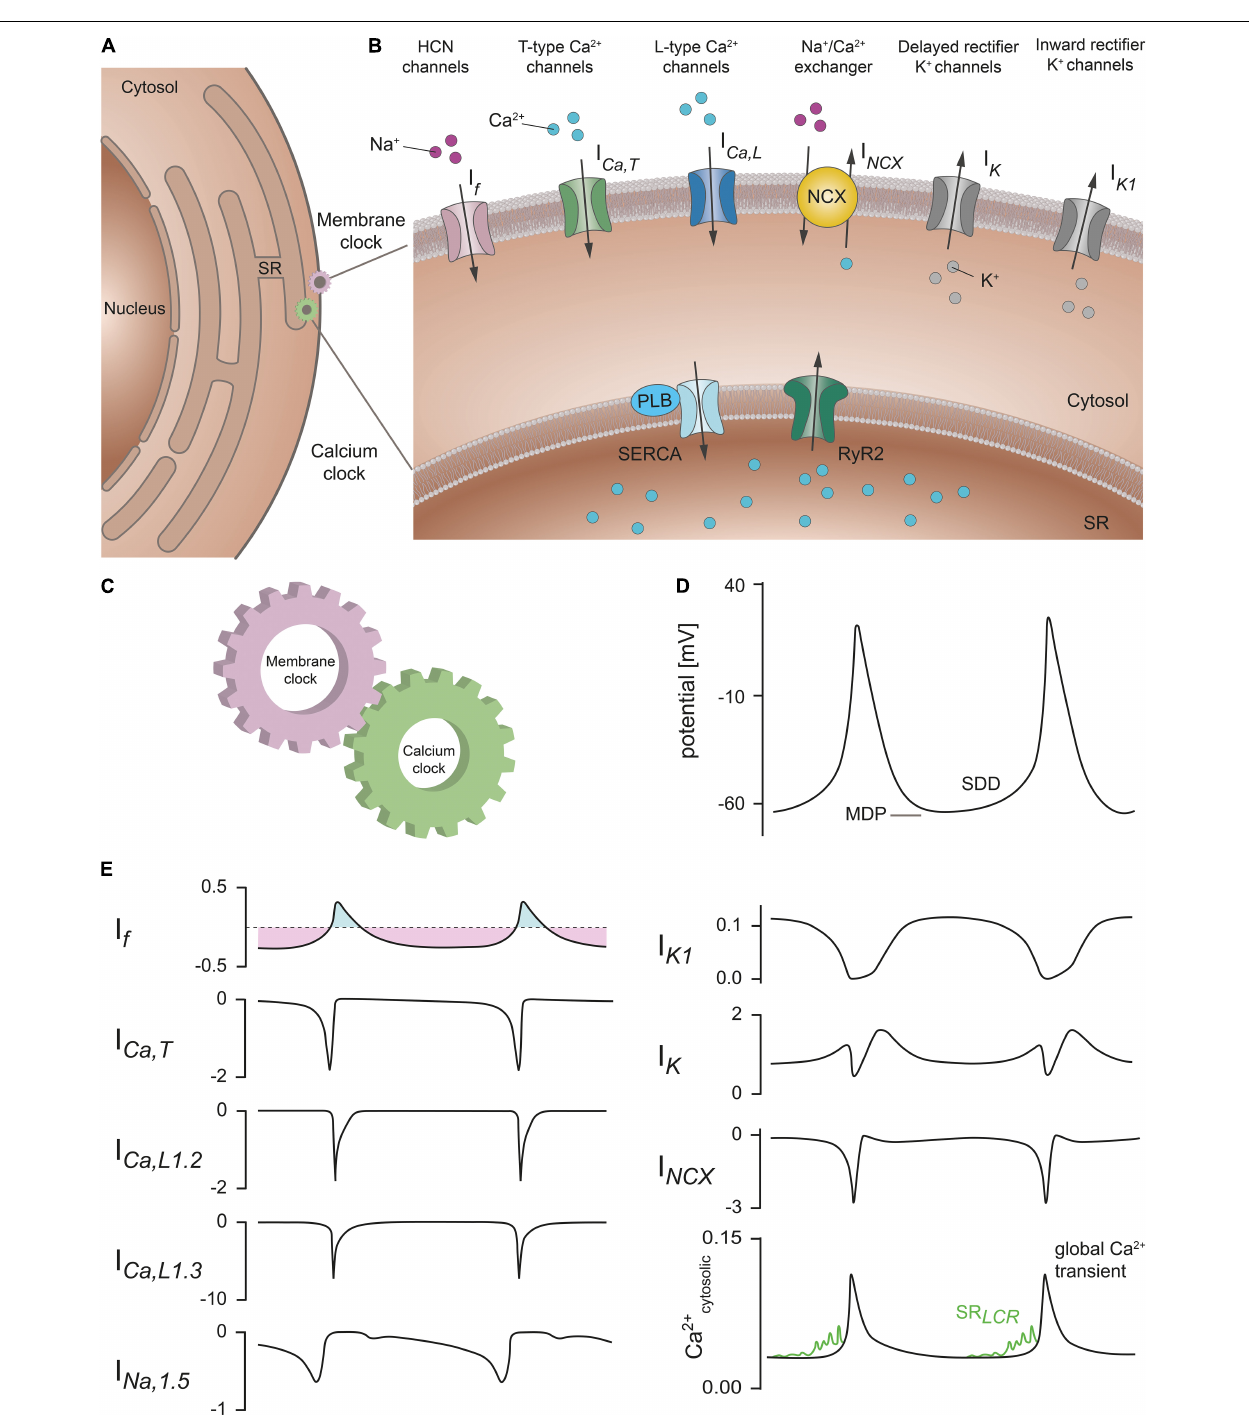
FIGURE 2 | Membrane and calcium clock contribute to the generation of SDD. (A) Schematic representation of a SAN cell containing the nucleus, cytosol, and sarcoplasmic reticulum (SR). (B) Section of the cell with a magnified view of the plasma membrane and SR membrane. Various proteins that contribute to SDD and are localized in the plasma membrane are collectively described as the membrane clock . These include hyperpolarization-activated cyclic-nucleotide gated (HCN) cation channels (pink), T-type Ca 2 + channels (green), L-type Ca 2 + channels (blue), Na + /Ca 2 + exchanger proteins (NCX, yellow), rapid and slow delayed rectifier K + channels (gray), and inward rectifier K + channels (gray). The corresponding ionic currents (I) are indicated. Intracellular Ca 2 + cycling events that contribute to the pacemaker process are summarized as calcium clock . Among them are sarco-/endoplasmic reticulum Ca 2 + ATPases (SERCA) (light blue) associated with the regulatory protein phospholamban (PLB) and ryanodine receptors (RyR2) (dark green) located in the SR membrane. (C) Functional interaction of the membrane